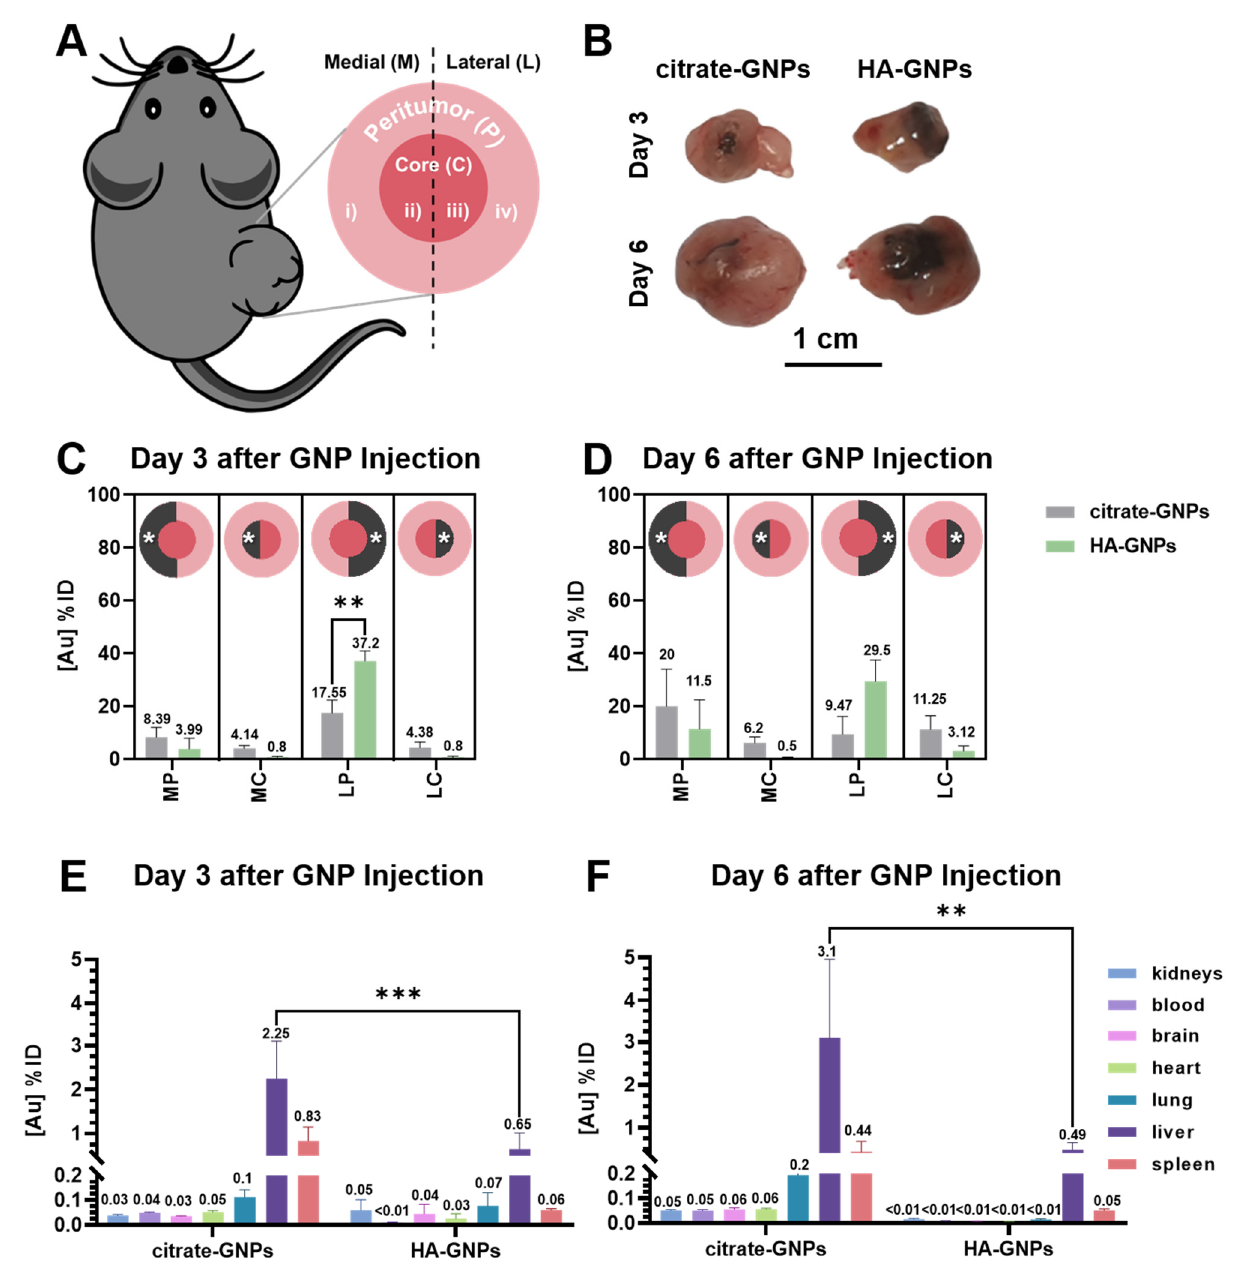
Figure 3. In vivo assessments and quantification of GNP distribution in a murine NSCLC model. ( A ) Schematic of tumor growth and atlas reference for the ex vivo analysis. Tumors were divided in medial and lateral halves (in reference to the mouse body positioning) and each half was subdivided into peritumor and core using a surgical blade. ( B ) Photos of ex vivo LLC tumors taken three and six days after intratumoral injection of citrate-GNPs and HA-GNPs. Tumors were photographed exposing only the lateral side, which allows for better appreciation of the GNP distribution with gross inspection (black areas represent particle clusters). Under the same experimental conditions, HA-GNPs distribute site-specifically in the lateral side of the tumor, while citrate-GNPs remain close to the injection site (in the center of the tumor). Elemental analysis performed using ICP-OES on resected tumors ( n = 4/group) allow for site-specific comparisons between the citrate-GNPs and HA-GNPs ( C ) three days or ( D ) six days post GNP injection. Biodistribution of GNPs in organs calculated using ICP-OES, where gold concentration in each organ is quantified as percentage of injected dose of GNP (% ID) ( E ) three days or ( F ) six days post GNP injection. A two-way ANOVA test was performed to compare the interactions between each group (** p < 0.005, *** p < 0.001, Tukey’s multiple comparisons test).